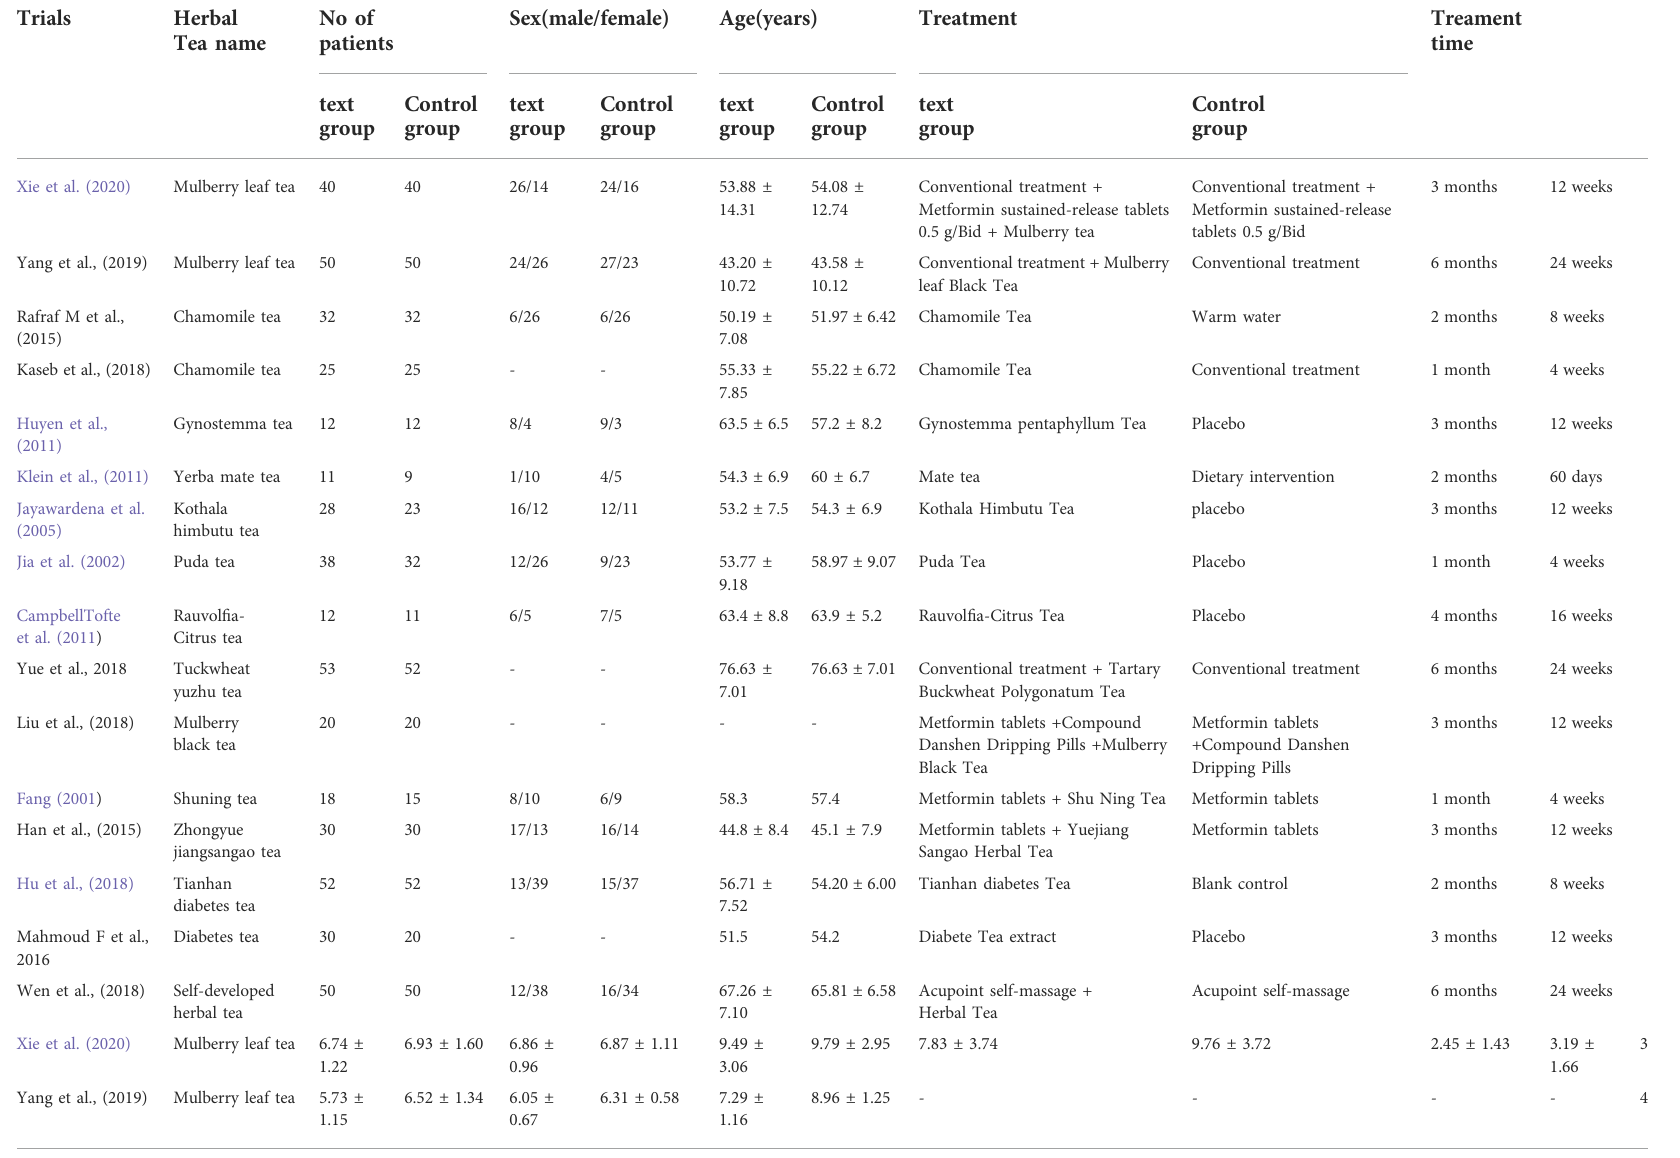
TABLE 1 Effectiveness of HTs in the management of T2DM.